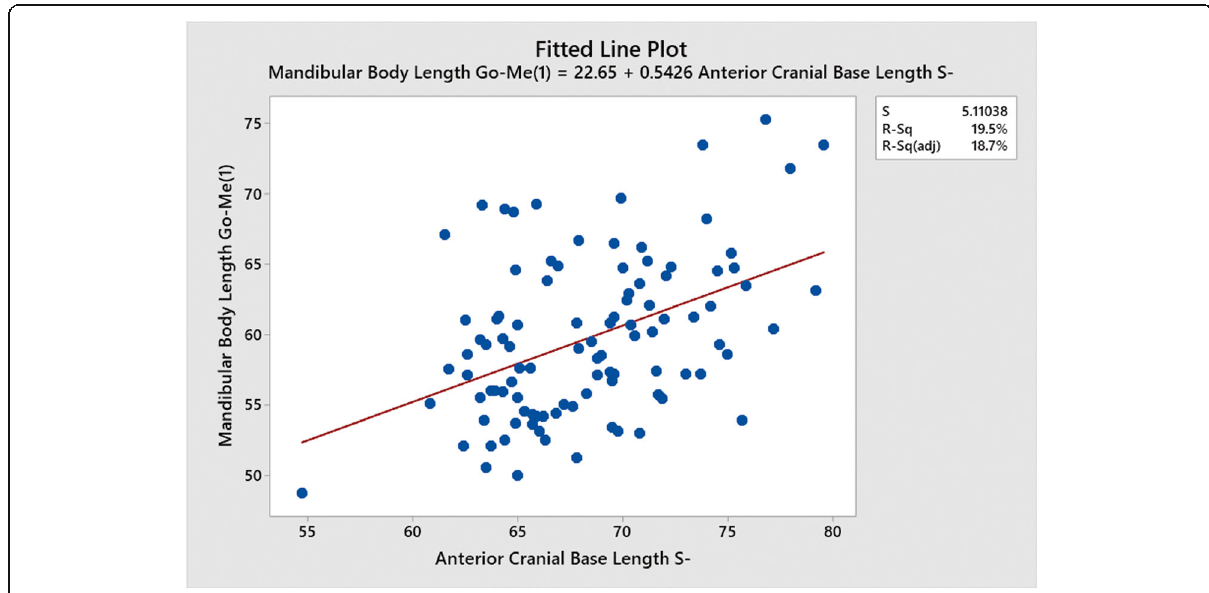
Fig. 8 Regression analysis between the length of the anterior cranial base (SN) and the length of the mandible (Go-Me)